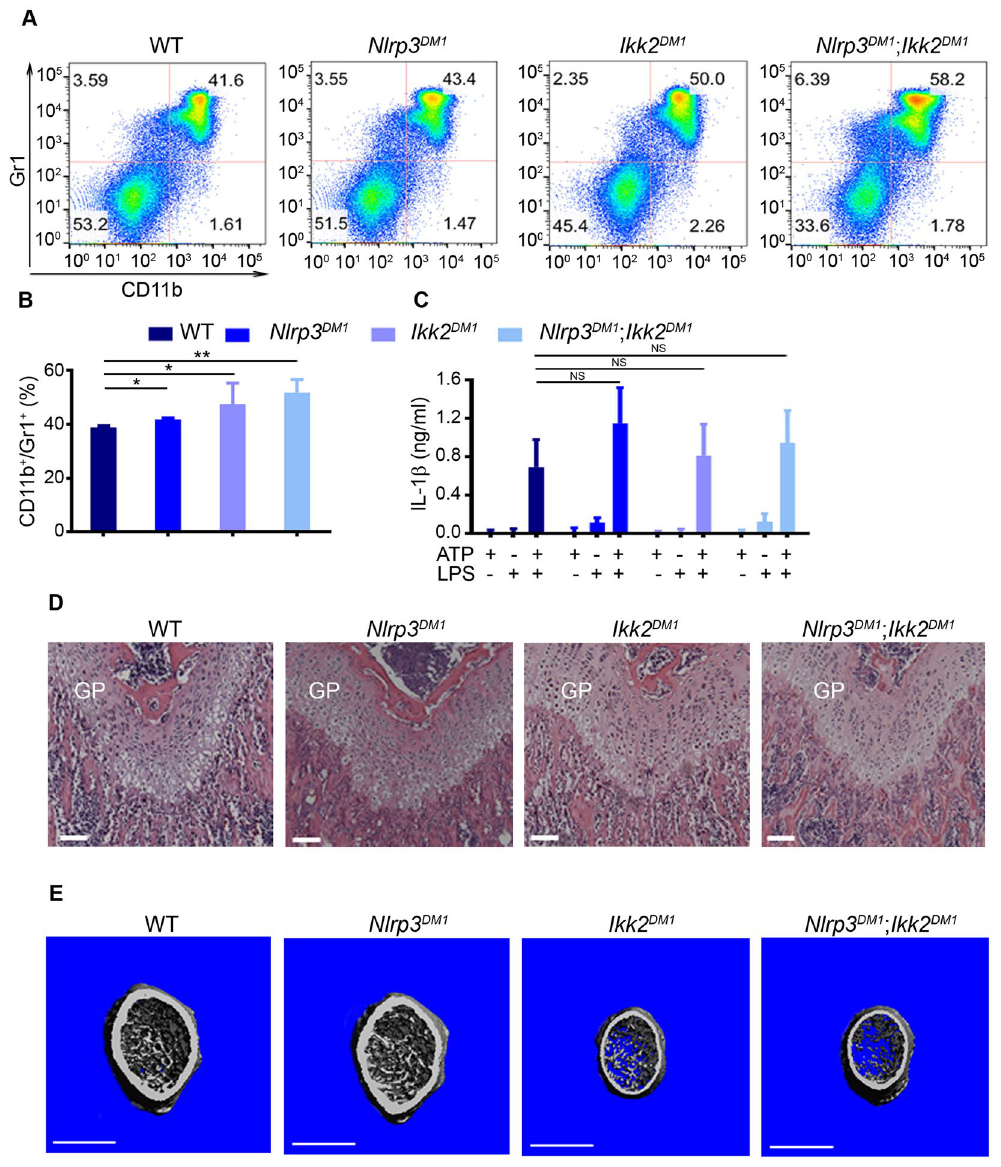
Figure 1. Constitutive activation of the NLRP3 inflammasome in osteochondro-progenitors does not cause inflammation and abnormal growth plate development. All data were obtained from 4-week old WT, Nlrp3 DM1 , Ikk2 DM1 or Nlrp3 DM1 ; Ikk2 DM1 male mice (n = 3–10/genotype). ( A ) Red blood cell-depleted bone marrow cells were stained with isotype control (data not shown) or with antibodies against CD11b and Gr1. Representative flow cytometry dot plots of the CD11b + /Gr1 + myeloid cells from each genotype are shown. ( B ) The percentage of CD11b + /Gr1 + cells in bone marrow cells. Data are expressed as mean ± SEM. * P < 0.05; ** P < 0.005. ( C ) IL-1 β levels in conditioned media from BMM treated with 100 ng/ml LPS for 3 hours, then with 5 mM ATP for 30 minutes. Data are expressed as mean ± SD of 3 independent experiments carried out in triplicates. NS, not significant. ( D ) H&E staining. GP, growth plate. Scale bar, 100 µ m. ( E ) 3D μ CT reconstruction of distal femoral metaphysis. Scale bar, 1